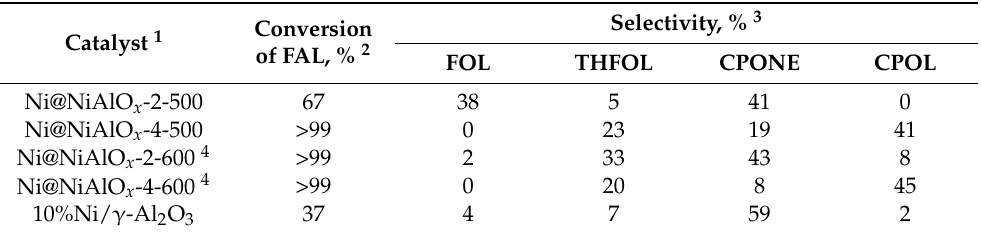
Table 5. Catalytic measurements in hydrogenation of FAL under harsh reaction conditions for Ni@NiAlO x samples differing in the Ni/Al atomic ratio and reduction temperature. Catalyst 1